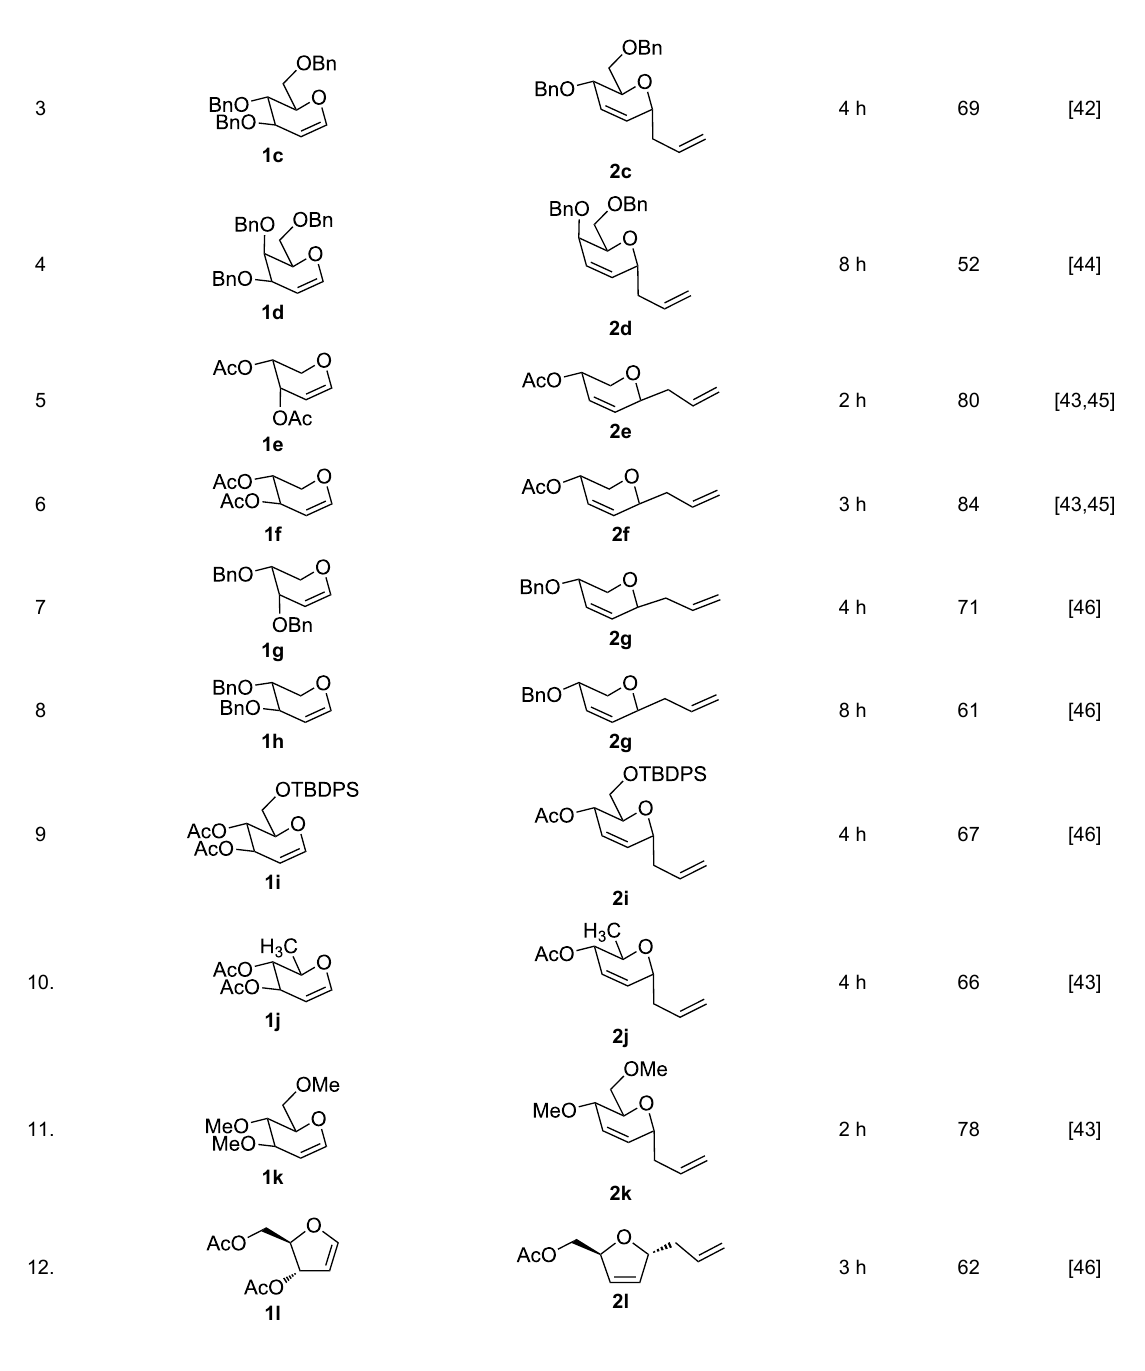
Table 2: Reaction of glycals with allyltrimethylsilane by using CAN.